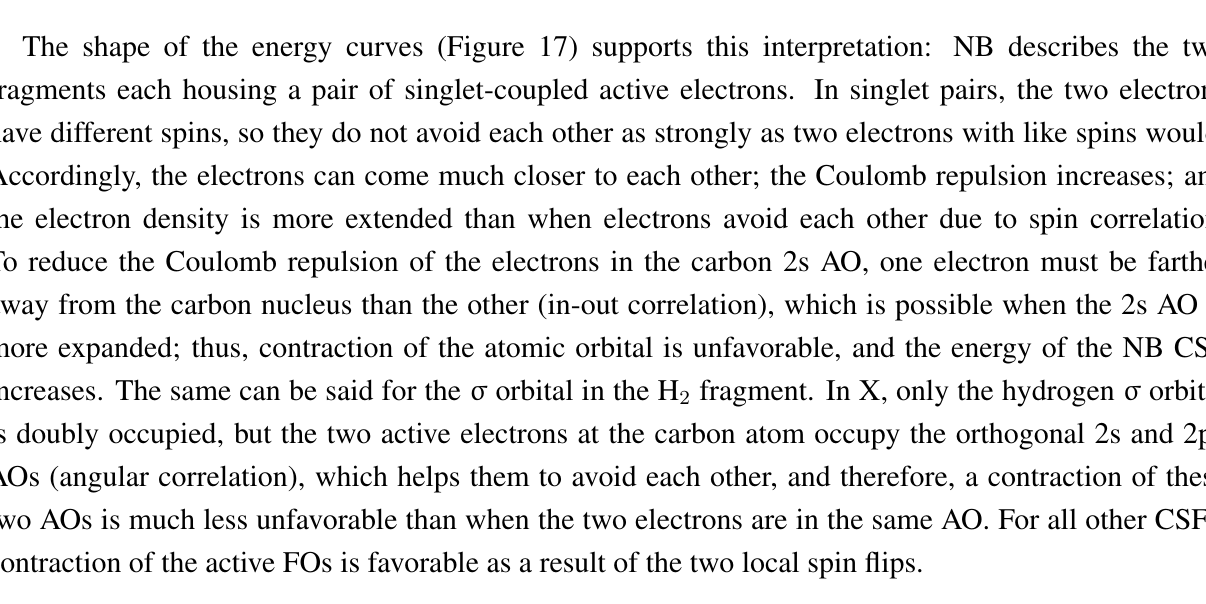
Figure 16. Carbene insertion into H in Hartrees; R in